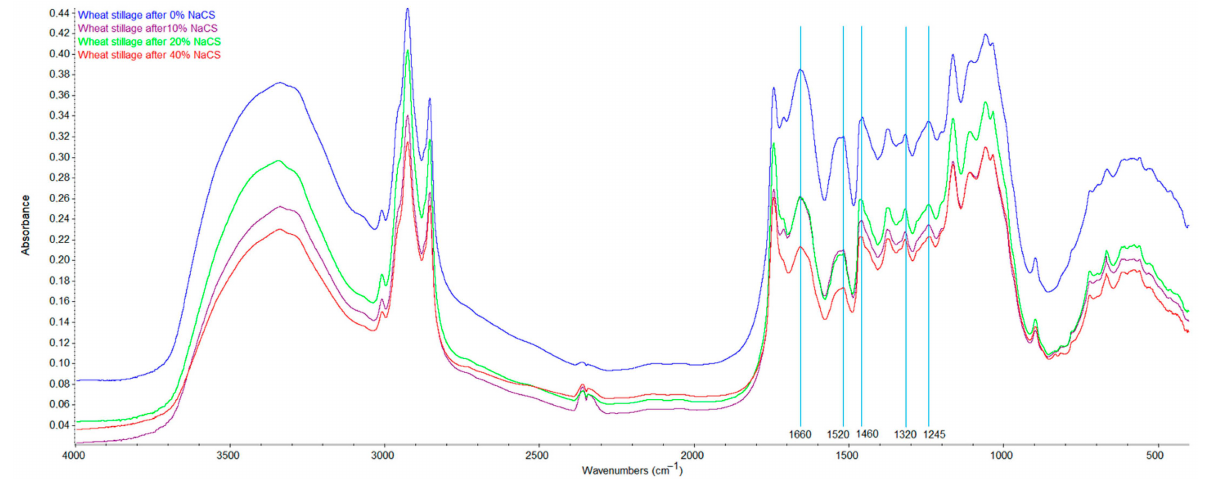
Figure 2. FTIR spectra of the wheat stillage samples after microwave-assisted hydrotropic